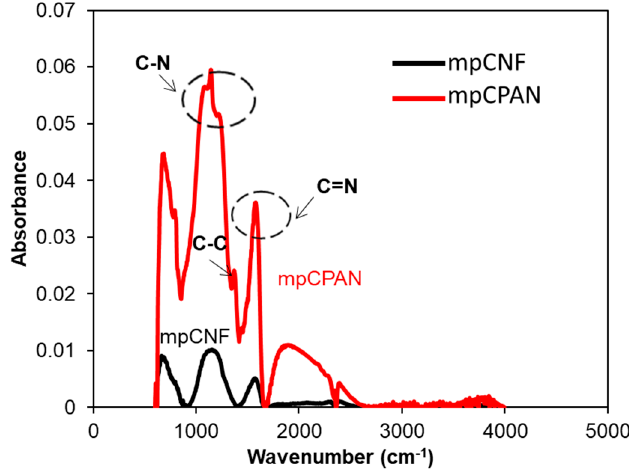
Figure 8. Experimental FTIR spectra of mpCNF and mpCPAN.